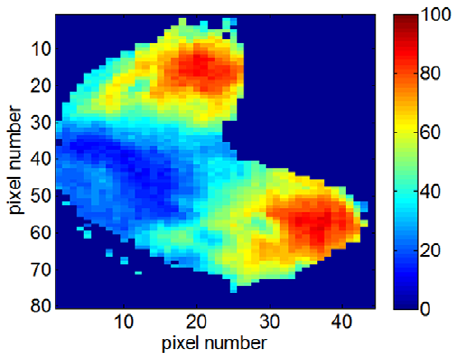
Figure 8. Receptive range of the rat olfactory receptors measured across the olfactory bulb. Less selective receptors are grouped in the medial-caudal and lateral-caudal parts of the olfactory bulb while selective receptors are located in the ventral region.